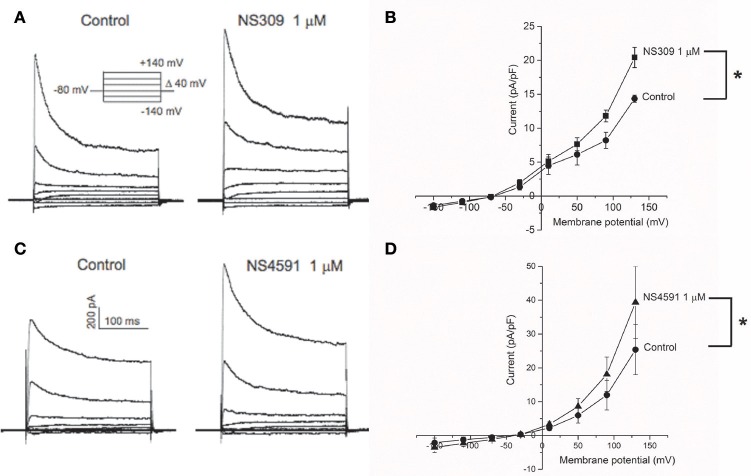
KCa2.x channels are functionally expressed in endothelial cells from corpus cavernosum. Whole-cell voltage clamp recordings from endothelial cells derived from primary culture of corpus cavernosum
(A–D). (A) Current evoked from voltage steps from −140 to +140 in control cells (left) or in presence of NS309 (1 μM; right). (B) Current-Voltage (I-V) relation in basal conditions (filled circles) and in response to 1 μM NS309 (filled squares). Results are means ± SEM. n = 4. (C) Current evoked from voltage steps from −140 to +140 in control cells (left) or in presence of NS4591 (1 μM; right). (D) I-V relation for control cells (filled circles) and in response to 1 μM NS459 (filled triangles). Results are mean ± SEM, n = 4. *P ≤ 0.05.